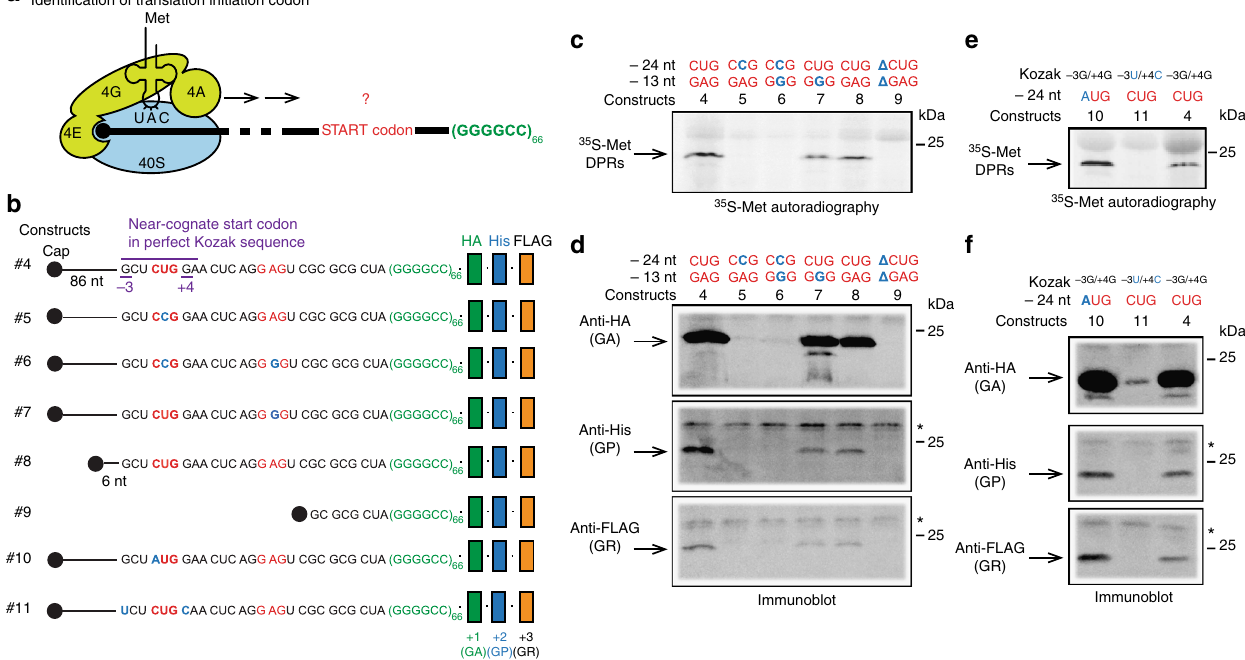
Fig. 3 G 4 C 2 RAN translation of all reading frames initiates at the same near-cognate CUG start codon in RRL. ( a ) Scheme of the pre-initiation complex loaded at the 5 ′ cap and the 40S ribosomal subunit ready to scan toward the start codon. RAN translation occurs in absence of an AUG codon. ( b ) Schemes of the transcripts #4 to #11 showing mutations in the 5 ′ fl anking sequence of (G 4 C 2 ) 66 used in ( c - f ). Construct #4 contains the native sequence of 113 nucleotides upstream of the G 4 C 2 repeat. Construct #5 has a CUG > CCG mutation (blue nucleotide) in a near-cognate start codon located in a perfect Kozak sequence 24 nucleotides upstream of the repeat. Construct #6 has CUG > CCG and GAG > GGG (blue nucleotides) mutations in two potential start codons located 24 and 13 nucleotides upstream of the repeat, respectively. Construct #7 contains a GAG > GGG mutation in a potential near-cognate start codon located 13 nucleotides upstream of the repeat. Constructs #8 and #9 harbor a deletion leaving 33 nucleotides (including CUG and GAG codons) and eight nucleotides (deleting both CUG and GAG codons) upstream of the repeat, respectively. Construct #10 has a CUG > AUG mutation in the near- cognate start codon. Construct #11 has GCUCUGG > UCUCUGC mutations in the Kozak sequence. ( c – f ) Translation was performed in presence of [ 35 S]- methionine using each RNA variant separately (#4 to #11). ( c and e ) [ 35 S]-methionine RAN translation products were detected by autoradiography. ( d and f ) Poly-GA, poly-GP, and poly-GR were detected by immunoblot using antibodies against HA-tag, His-tag, and FLAG-tag, respectively. Asterisk indicates unspeci fi c proteins translated in the RRL